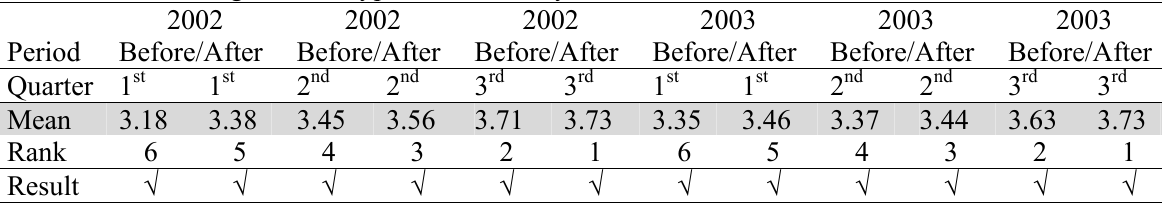
The results of testing the first hypothesis for the years of 2002-2003 2002 Period Before/After Before/After Before/After Before/After Before/After